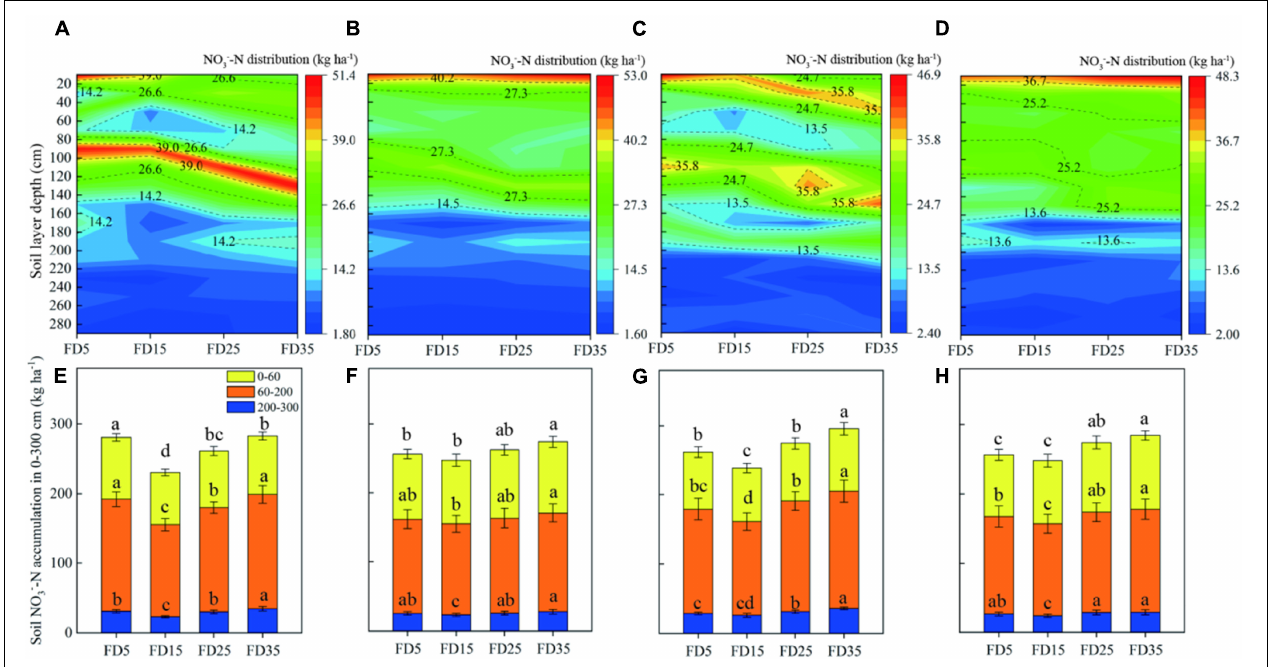
FIGURE 9 | Nitrate distribution in the 0–300-cm soil layer at the harvest stage of summer maize and winter wheat. Soil nitrate distribution (A,E) at the 2019 summer maize harvest stage, (B,F) at the 2019–2020 winter wheat harvest stage, (C,G) at the 2020 summer maize harvest stage, and (D,H) at the 2020–2021 winter wheat harvest stage. FD5, fertilizer application at a depth of 5 cm; FD15, fertilizer application at a depth of 15 cm; FD25, fertilizer application at a depth of 25 cm; and FD35, fertilizer application at a depth of 35 cm. The vertical bars stand for standard deviation. The different lowercase letters indicate a significant difference among the treatments at P < 0.05 using the LSD method.